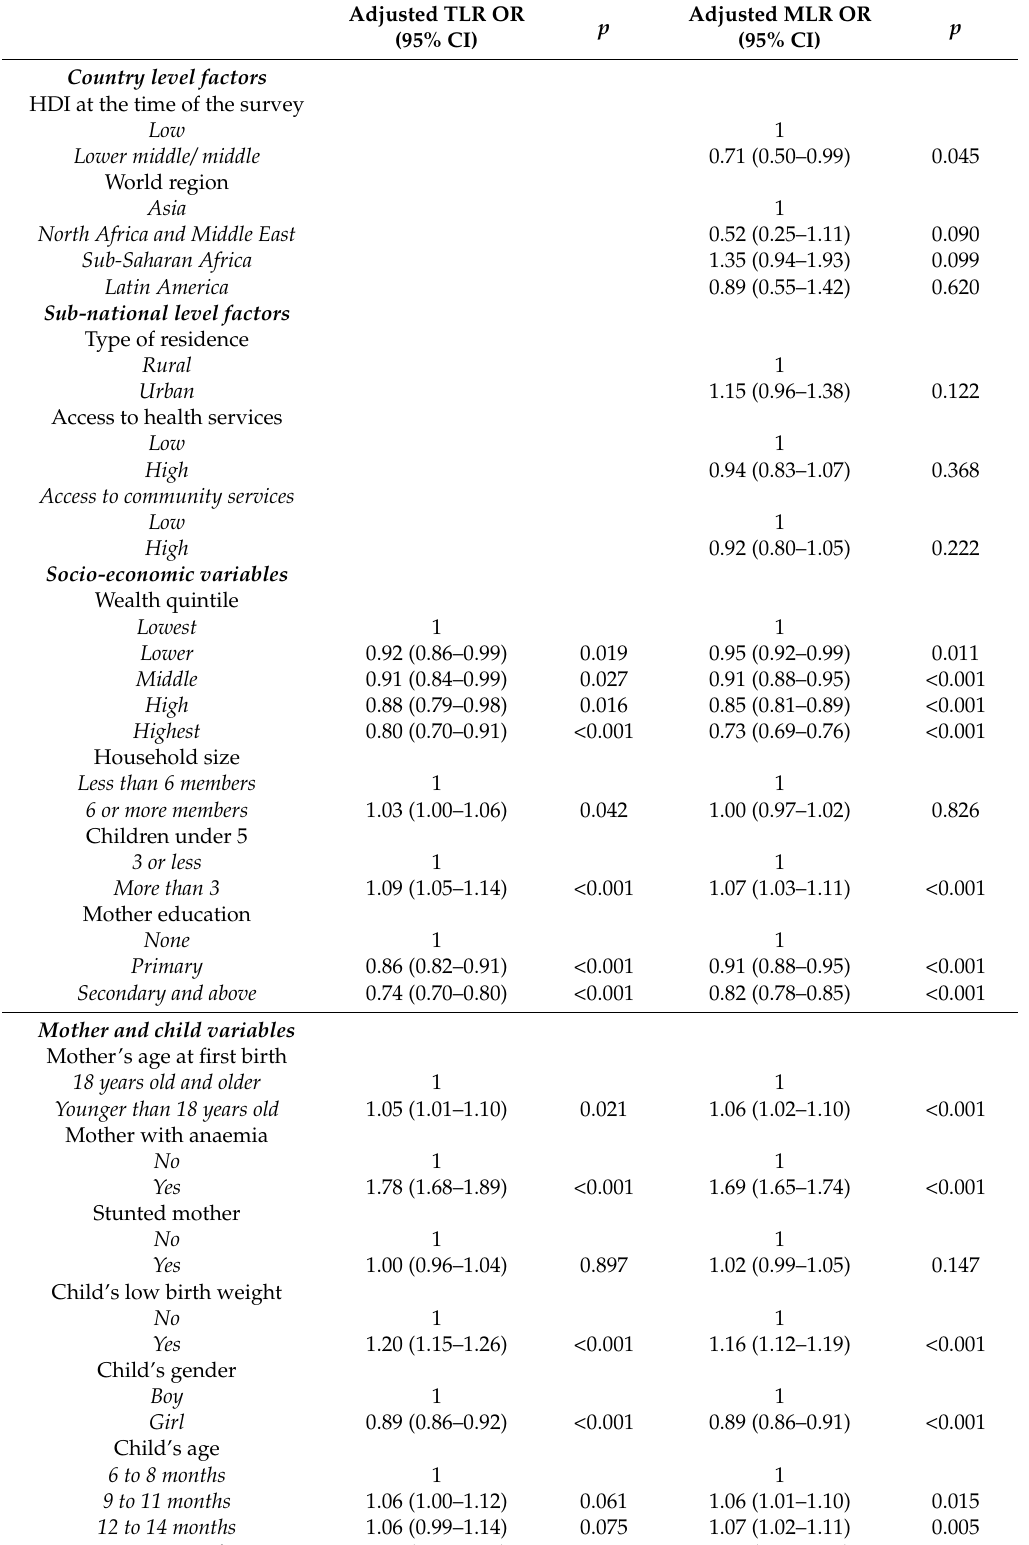
Table 1. Estimated odds ratios traditional logistic and multilevel logistic regressions on anaemia in children 6 to 23 months